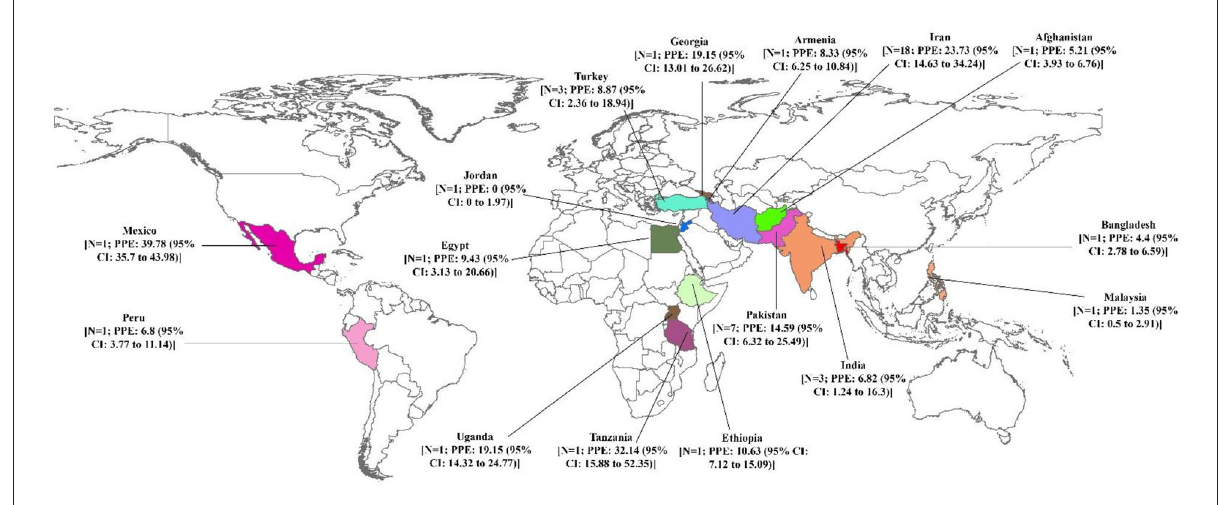
FIGURE4 Pooled prevalence with 95% confidence interval (CI) of brucellosis prevalence based on country.